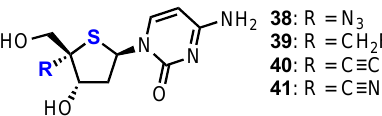
(cid:48) -deoxy-4 (cid:48) -thiacytidine nucleosides 38 – 41 Figure 4. Structures of 2 ′ -deoxy- 4’ -thiacytidine nucleosides 38 – 41 . Figure 4. Structures of 2